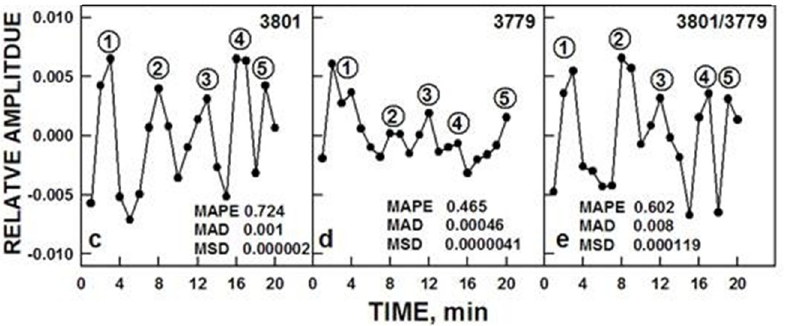
Figure 5. FTIR spectroscopic measurement of the ratio of para-H 2 O/ortho-H 2 O above a water sample surface determined at 3801 and 3779 cm − 1 , respectively. ( a ) The ratio